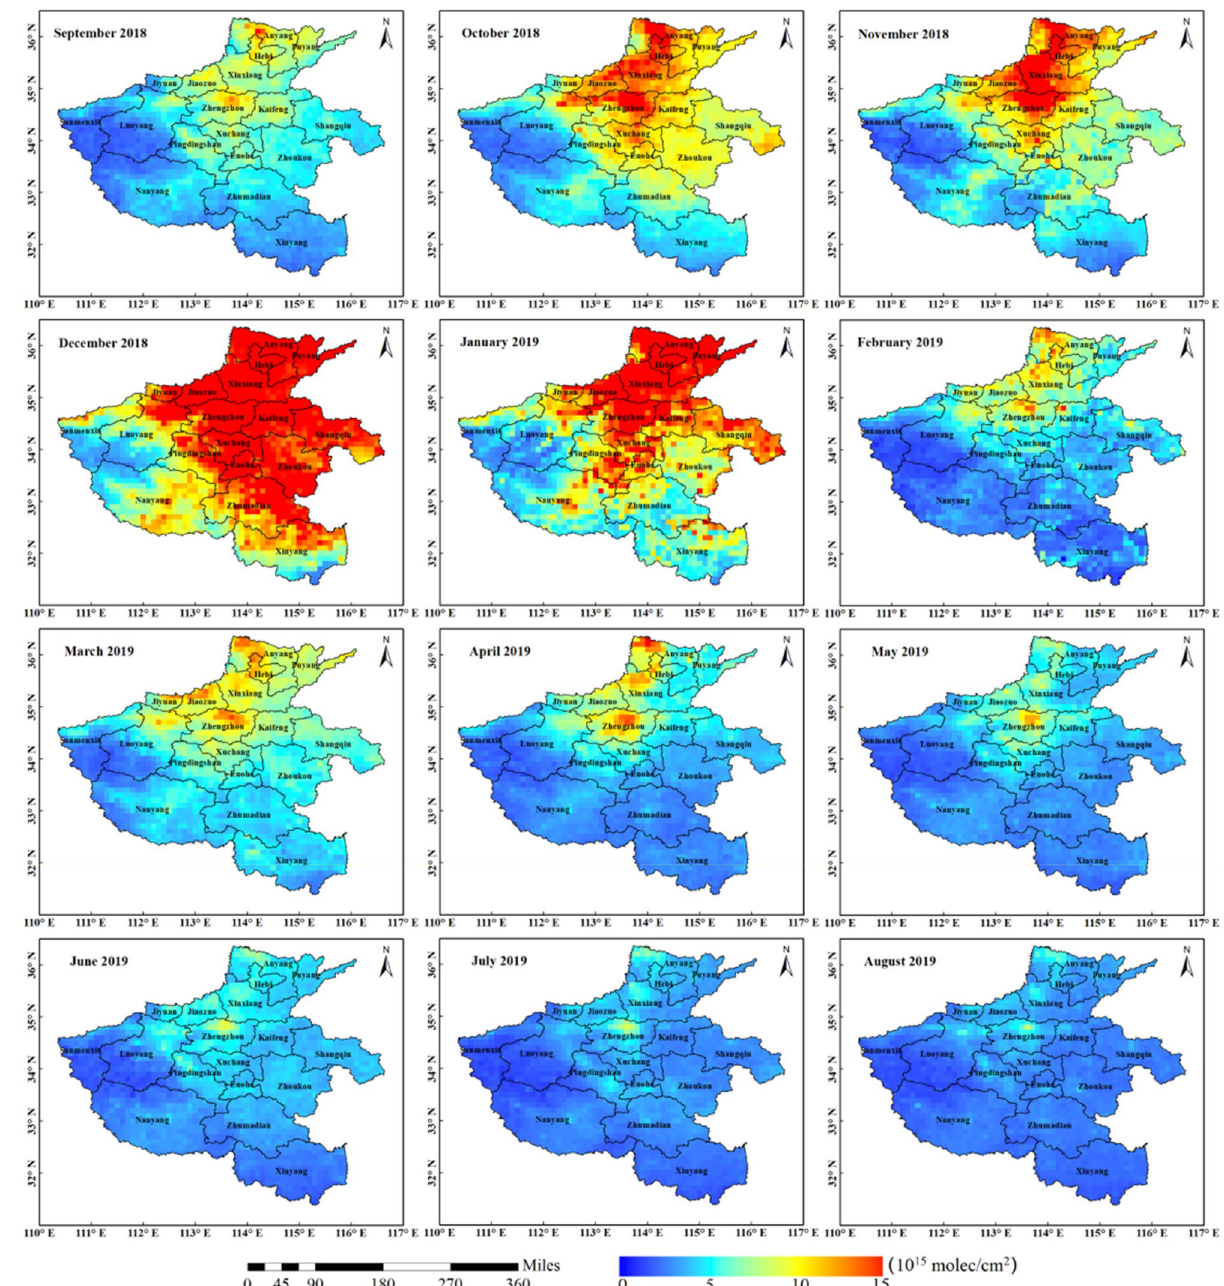
Figure 5. Monthly average distribution of TROPOMI NO 2 VCDs (× 10 15 mol/cm 2 ) of the COVID-19 early period from September 2018 to August 2019 in Henan